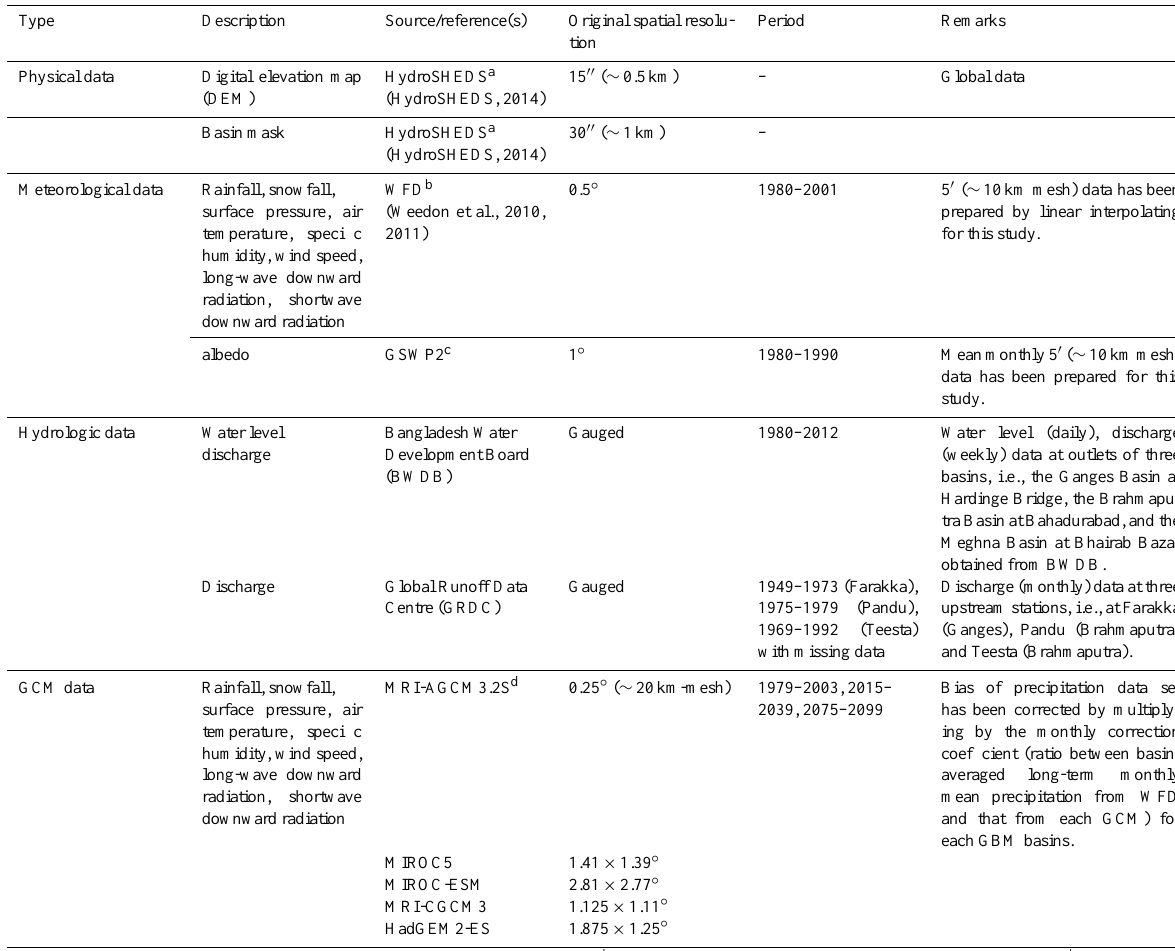
Table 2. Basic input data used in this study.